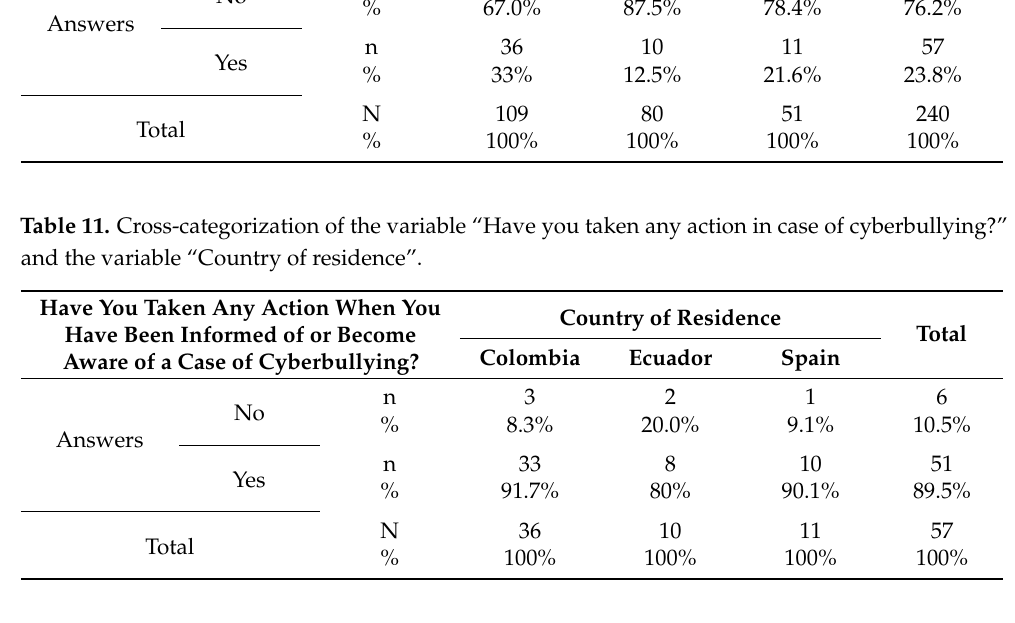
Table 12. Cross-categorisation of the variable “Main reason for not taking action when aware of cyberbullying” and the variable “Country of